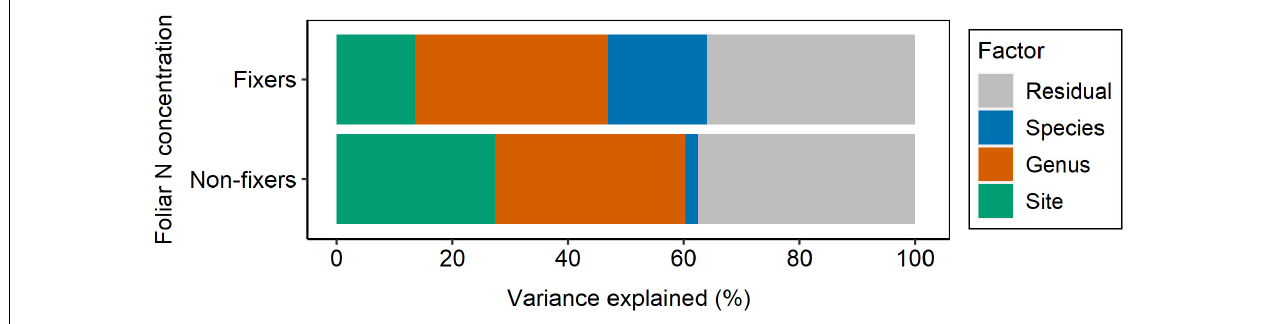
FIGURE 7 | Partitioning of variance for foliar N concentration of N 2 -fixing and non-fixing Fabaceae into taxonomy (nested design: genus/species), site, and residual.